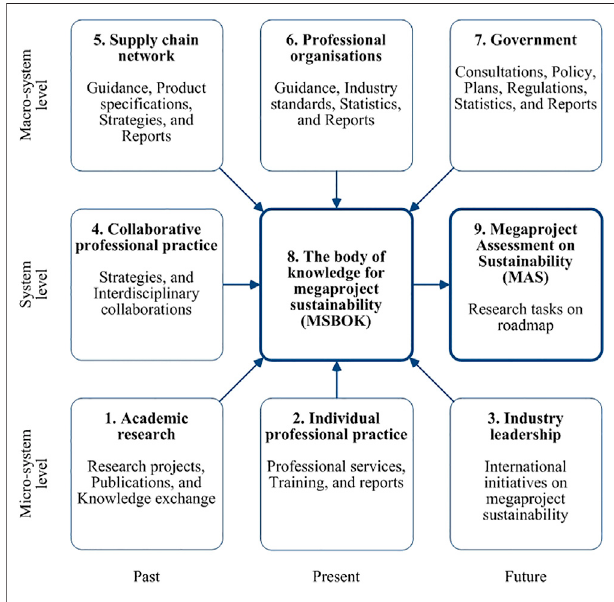
FIGURE 1 | A TRIZ approach to identifying research areas for